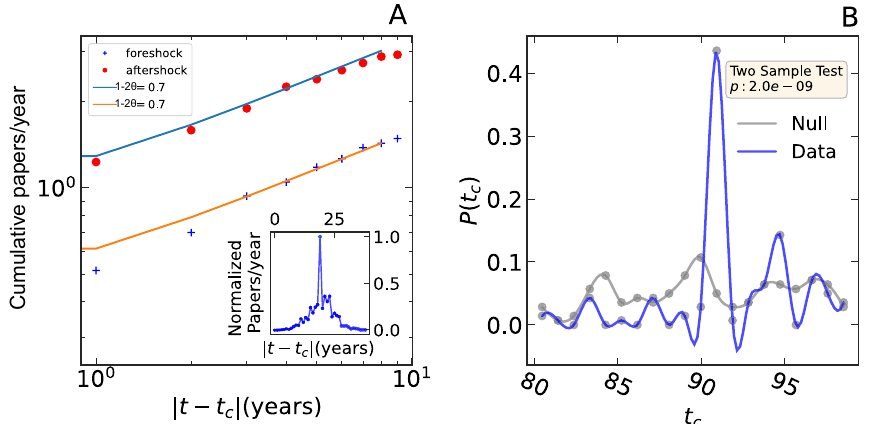
Figure 2. Synchronized endogeneity in scientific productivity: ( A ) cumulative precursory (“foreshock”) and relaxation (“aftershock”) of renormalized scholarly annual productivity of 140 scholarly careers. The exponents of scaling laws are 0.7. The inset figure shows the peak-centered average annual scholarly productivity. ( B ) The probability distribution of time of maximum annual productivity in scholarly careers (in blue). The distribution of time of maximum productivity in randomly distributed publications within the careers (in gray). The p value of two-sample Kolmogorov–Smirnov test result is given in the yellow box.